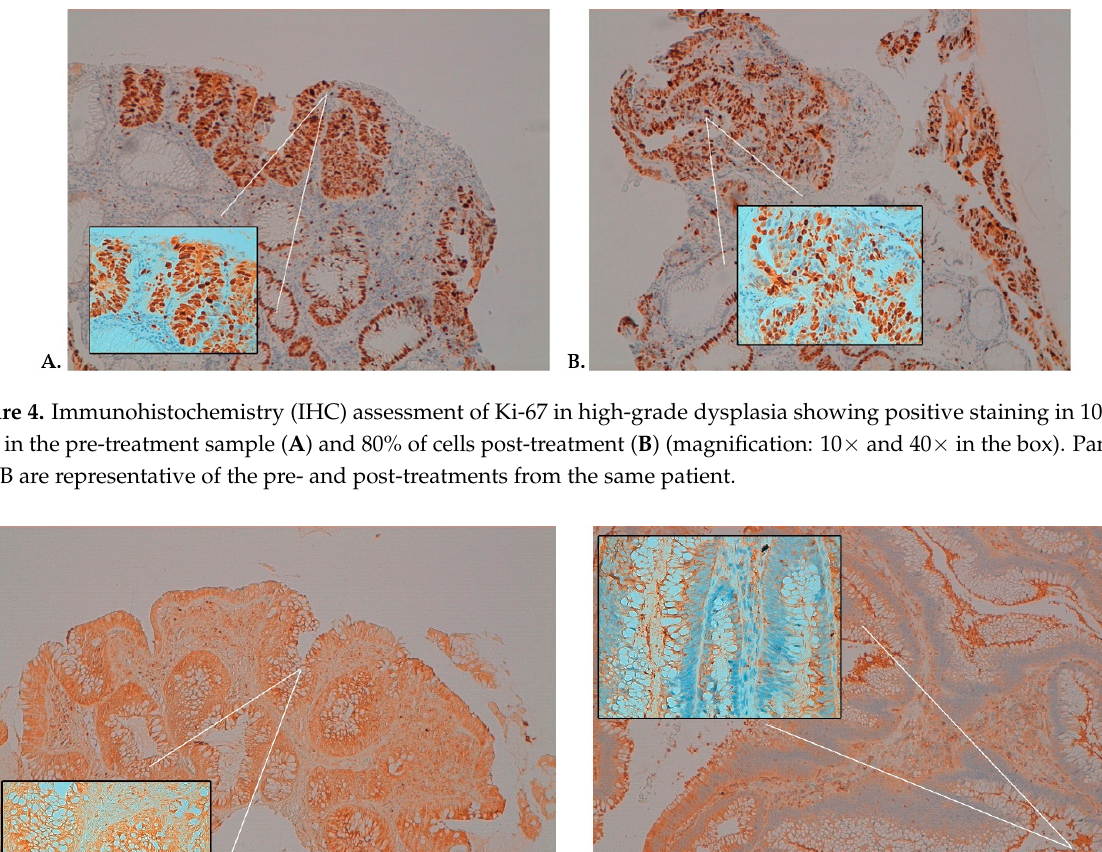
A. B. Figure 5. Immunohistochemical assessment of NF- κ B-p65 protein in high-grade dysplasia showing positive cytoplasmic staining in 80% of cells in pre-treatment tissue sample ( A ) and 60% of cells in post-treatment samples ( B ) (magnification: 10× and 40× in the box). Panels A and B are representative of the pre- and post-treatments from the same patient.